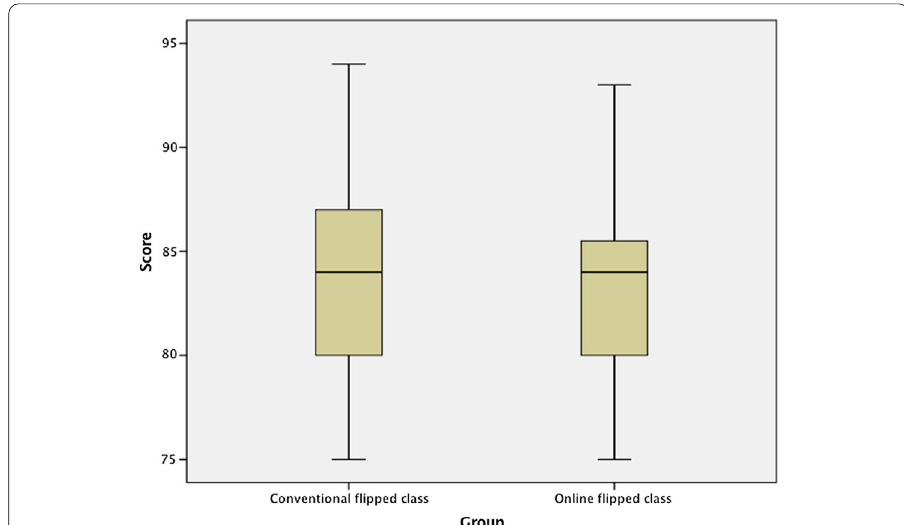
Fig. 9 The boxplots of final marks in Course 2 for conventional flipped class and online flipped